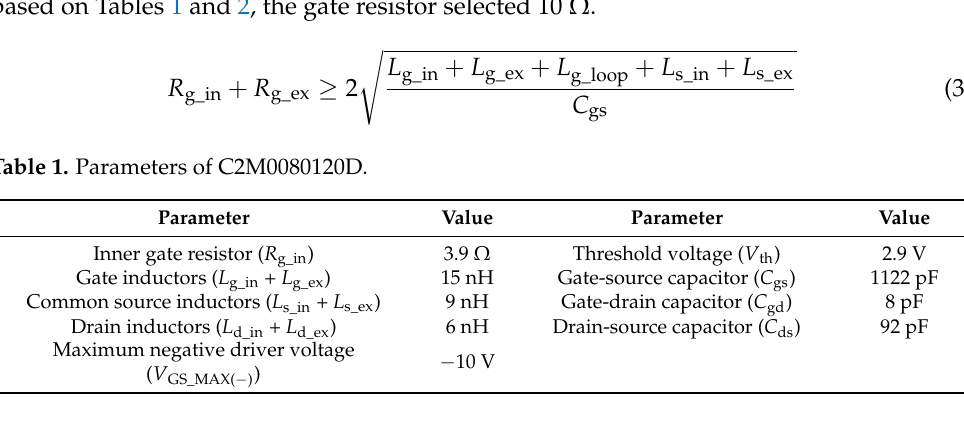
Table 2. Parameters of the simulation model based on synchronous buck and proposed